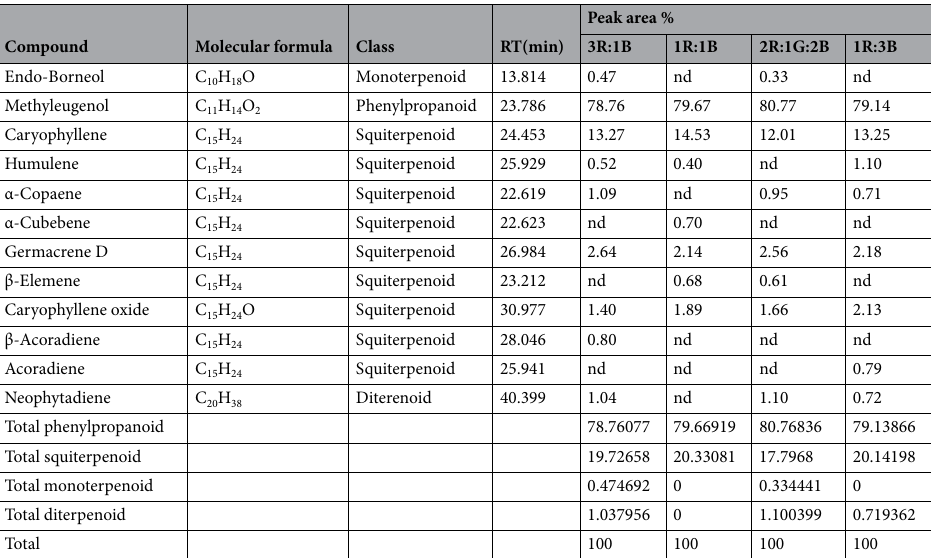
Table 4. Chemical profiling of red holy basil under different light spectrum ratios (3R:1B, 1R:1B, 2R:1G:2B, and 1R:3B) at vegetative stage. “nd” indicates not detected . R, G and B represent the red, green and blue llight spectra, respectively, and number before the letters stand for the ratio of each lighrt